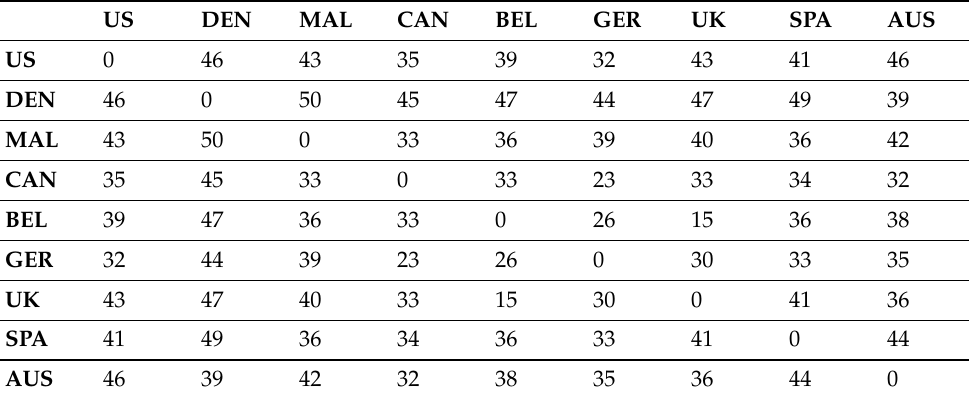
Table A3. Jaccard distances based on the combined Tables 1 and 2 from [13]. The guidelines are about the management of non-specific lower back pain.